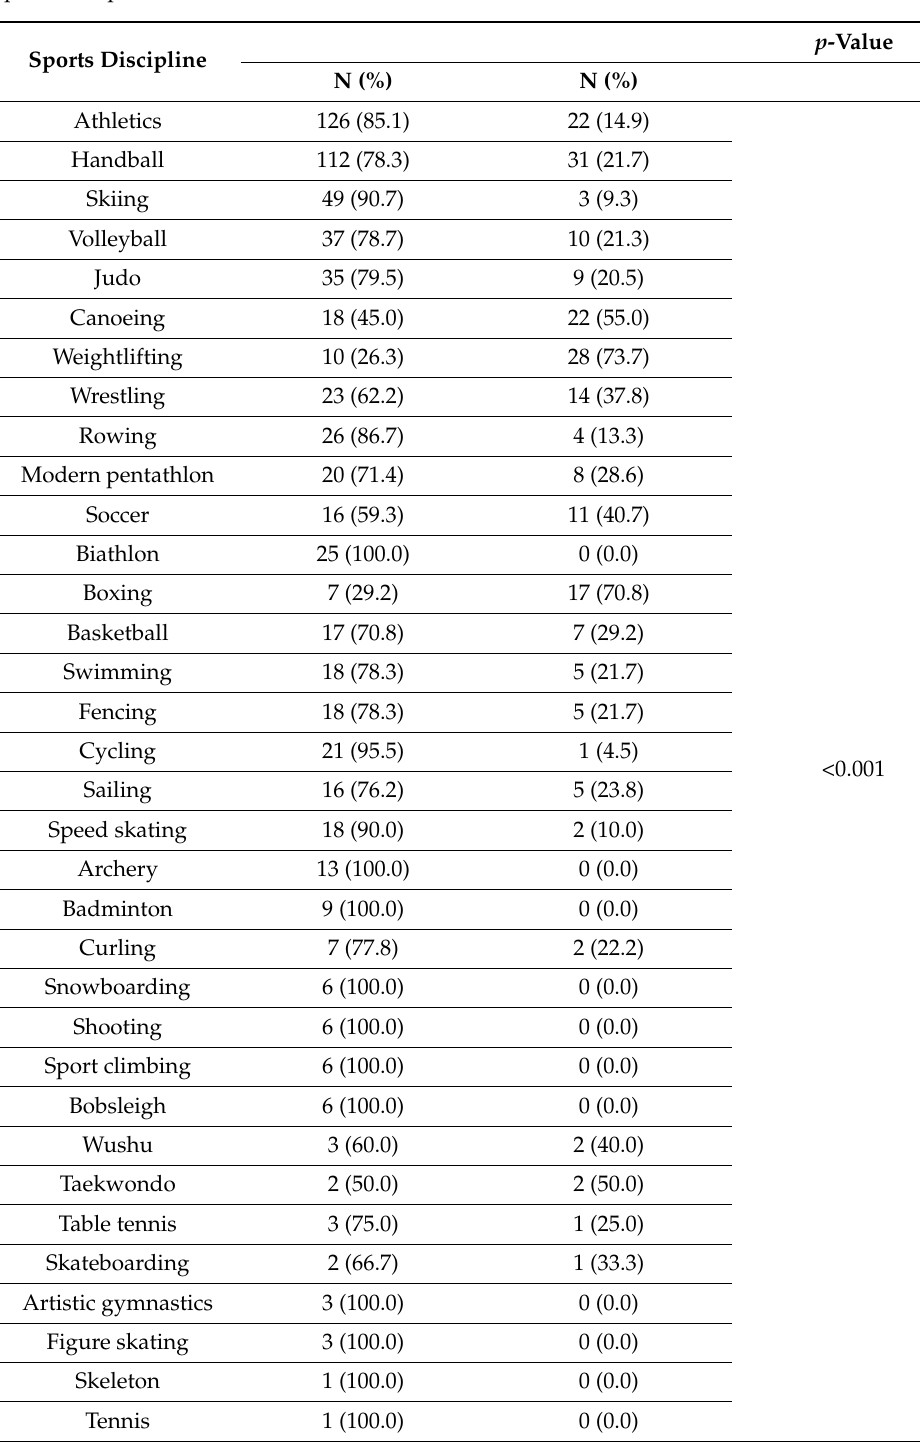
Table 2. Vaccinated (VA, n = 683) and unvaccinated (NVA, n = 212) against COVID-19 by sports